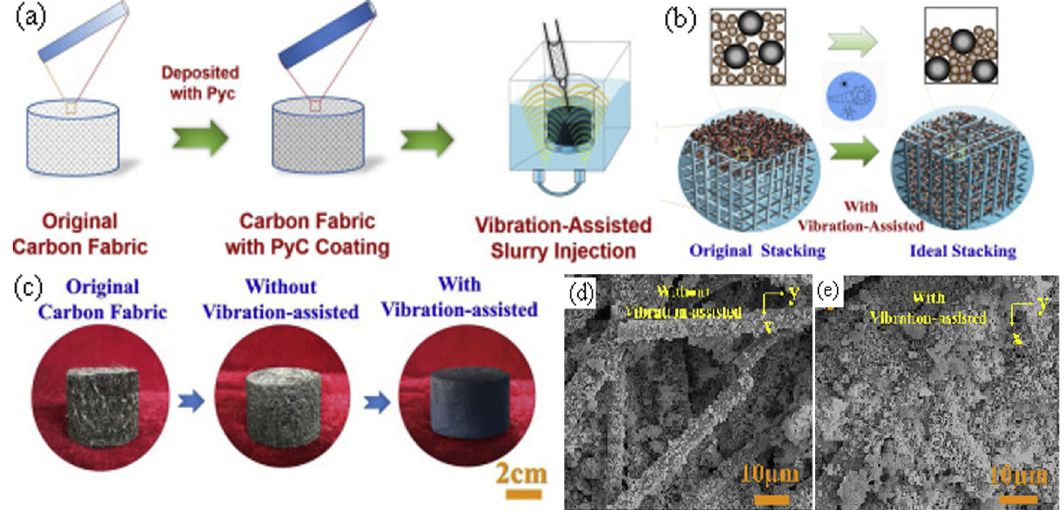
Figure 6: The process of vibration - assisted slurry injection and the e ff ect of vibration on the ceramic distribution: ( a ) schematic diagram of vibration - assisted slurry injection, ( b ) the schematic diagram of how ultrasonic vibration a ff ects the stacking and distribution of nanosized ceramic granules, ( c ) the macrographs during the process, ( d ) the internal microstructures along the x – y plane of carbon fabric after non - vibration - assisted injection, and ( e ) the internal microstructures along the x – y plane of carbon fabric after vibration - assisted injection [ 81 ]